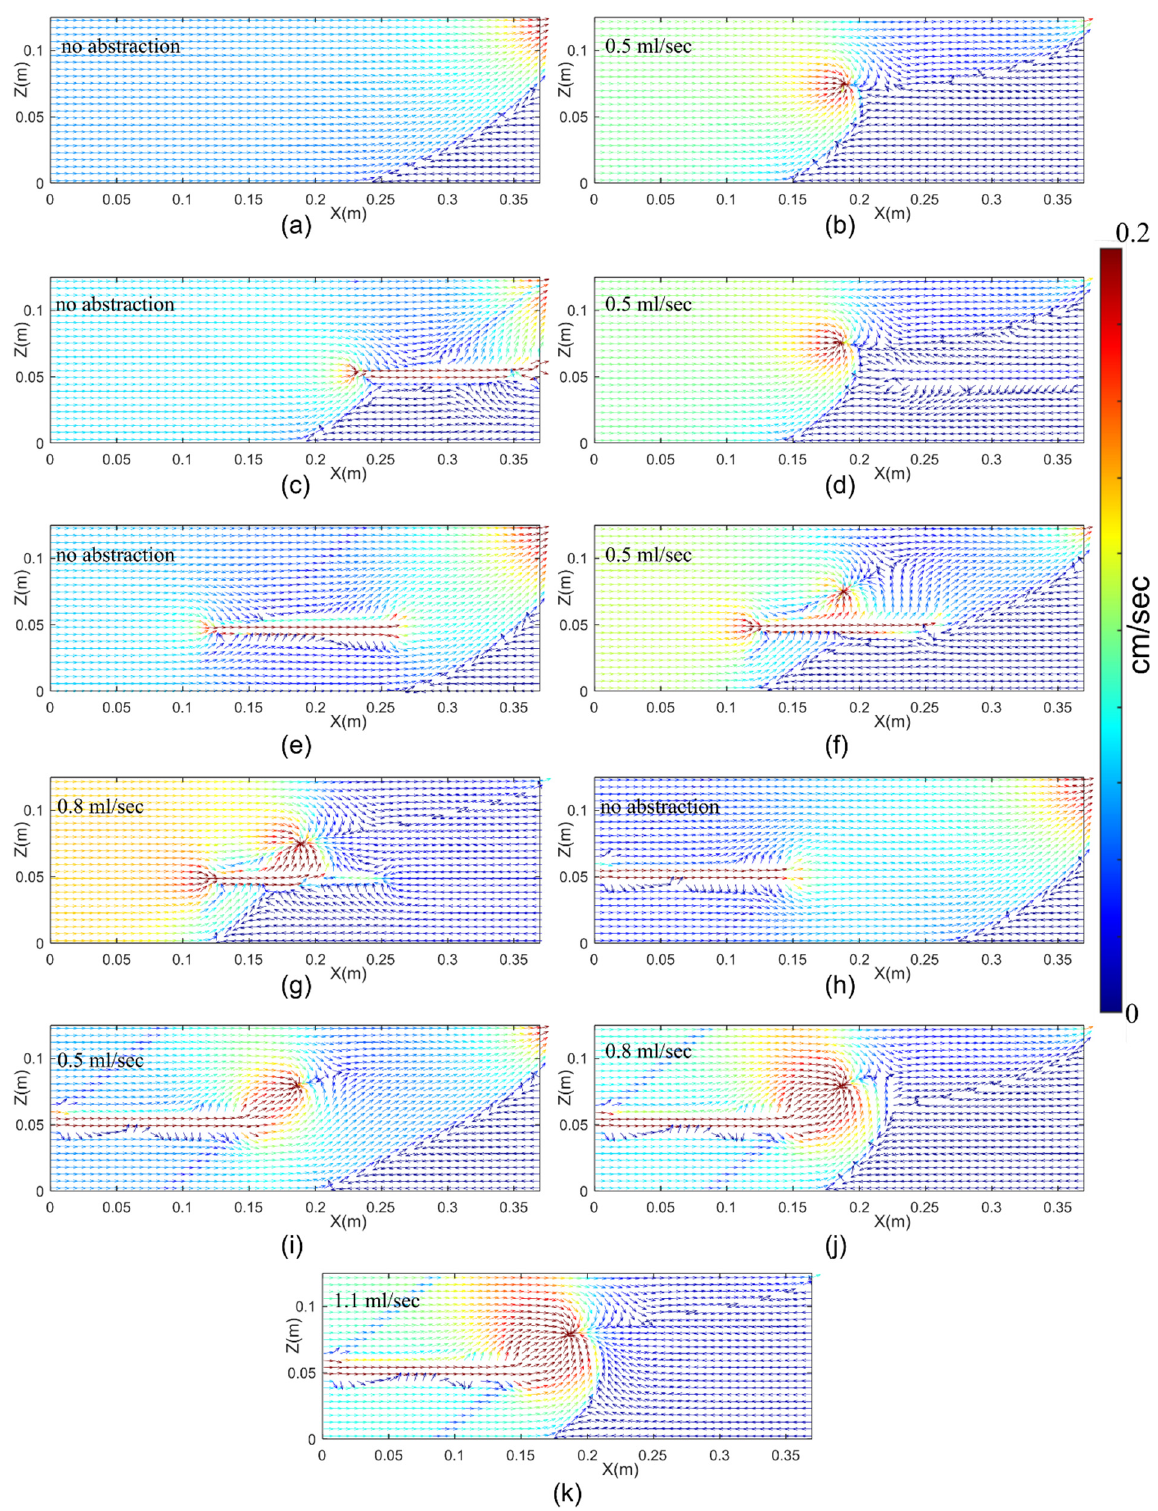
Figure 3. Flow velocity vector fields, generated during the initial pre-pumping experimental phase and for the various abstraction rates applied in the fractured-right ( c , d ), fractured-center ( e – g ) and fractured-left ( h – k ) laboratory aquifers and in a benchmark homogeneous case ( a , b ) with the same porous medium characteristics.